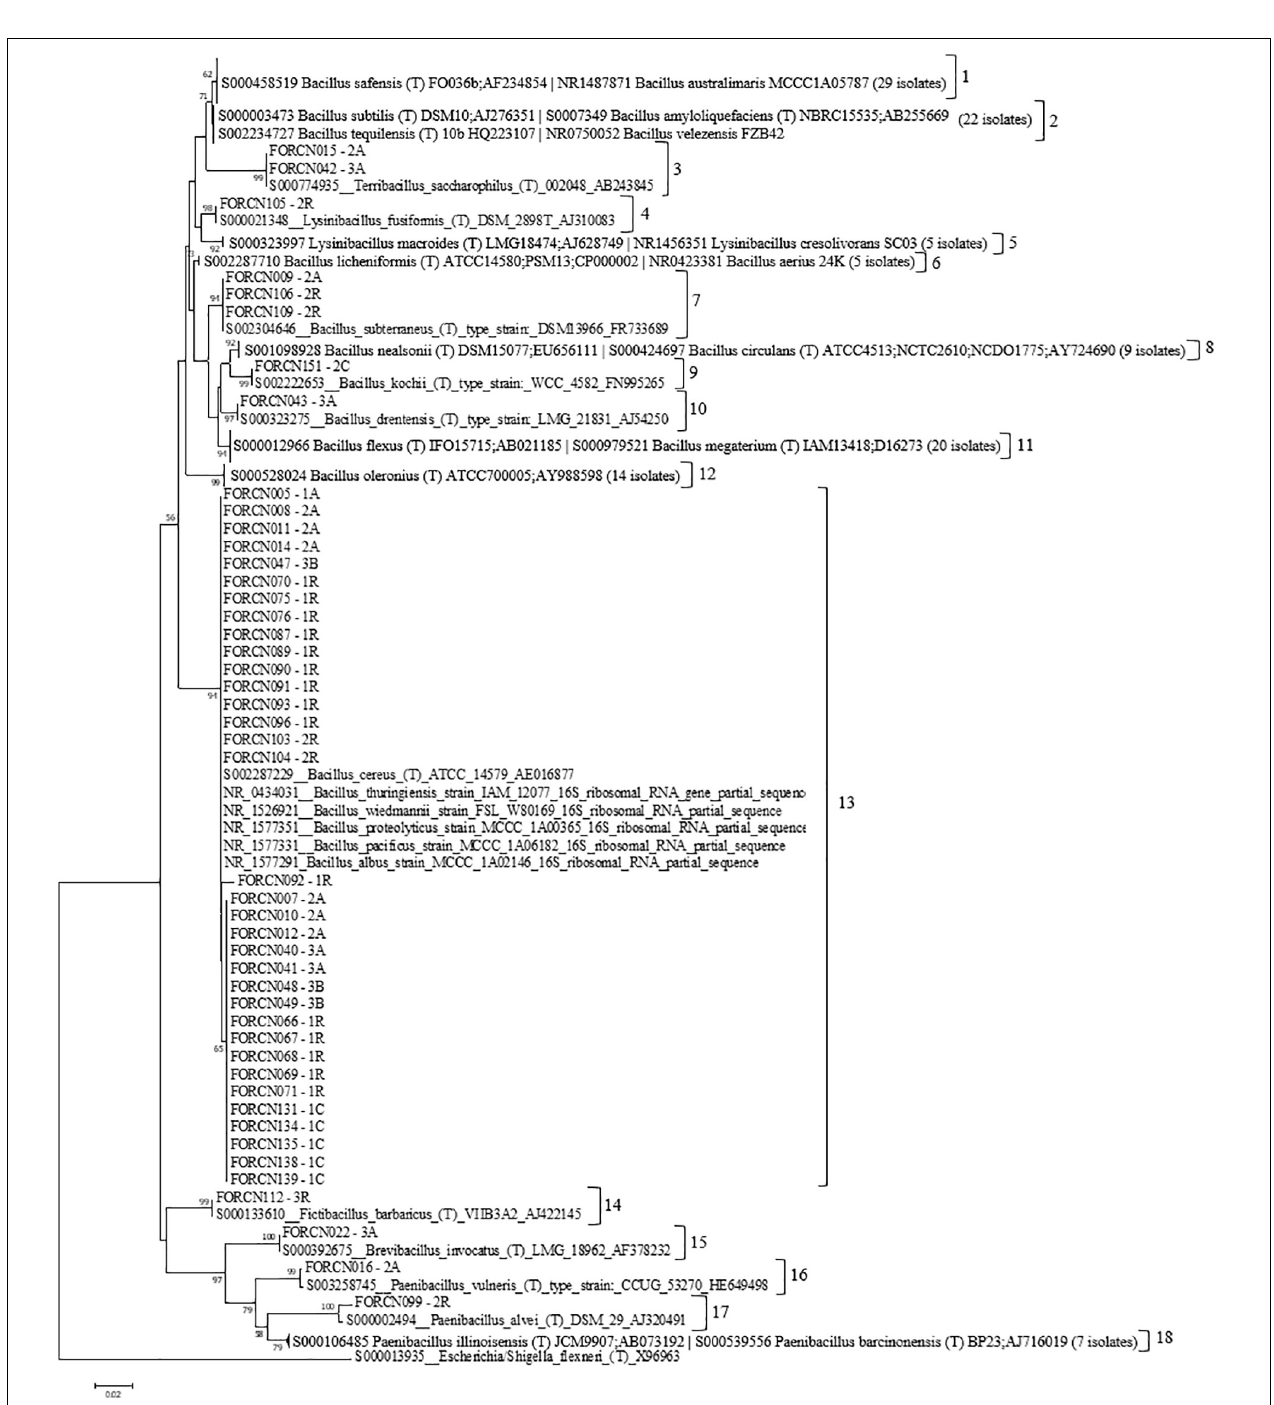
FIGURE 3 | Phylogenetic relationships of bacteria isolated from different sugarcane niches estimated based on the 16S rRNA sequence. The tree was obtained using the Neighbor-Joining (NJ) statistical method and the Tamura 3-parameter model as indicated by the model test function of the MEGA 7.0 program. Bootstrap values are shown when the represented relationships have been observed in at least 50% of 1000 replicates. Escherichia / Shigella flexneri was used as an external group. The numbers 1–18 indicate the groups formed.